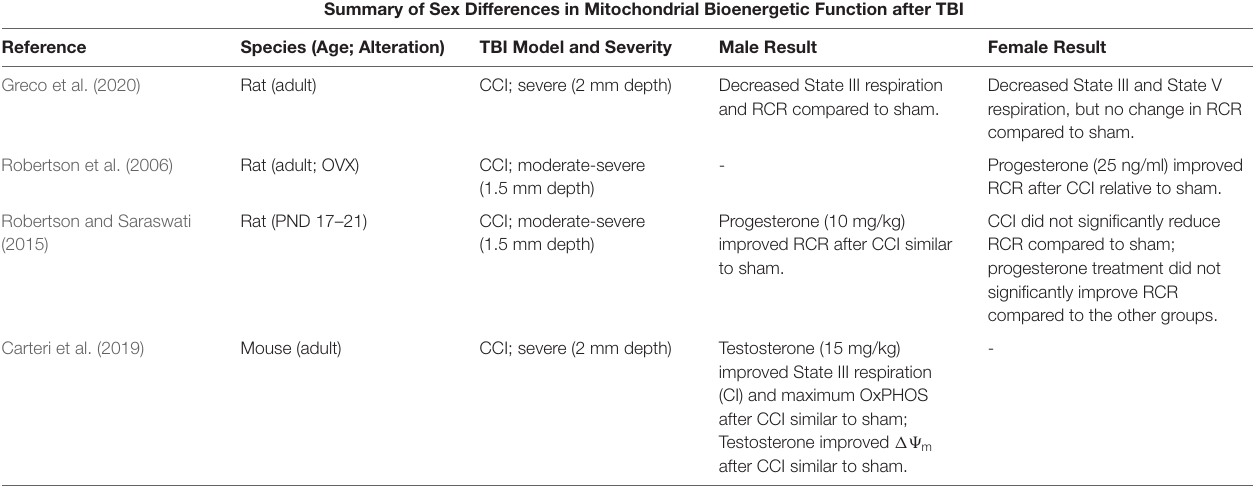
TABLE 1 | Summary of literature in sex differences in mitochondrial dysfunction following